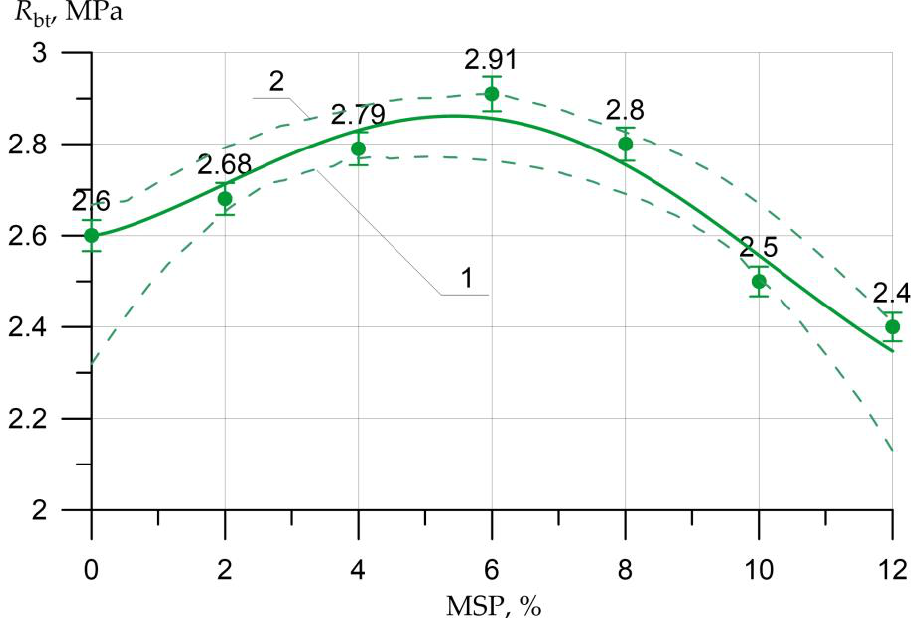
R on the amount of MSP: 1 — lower confidence